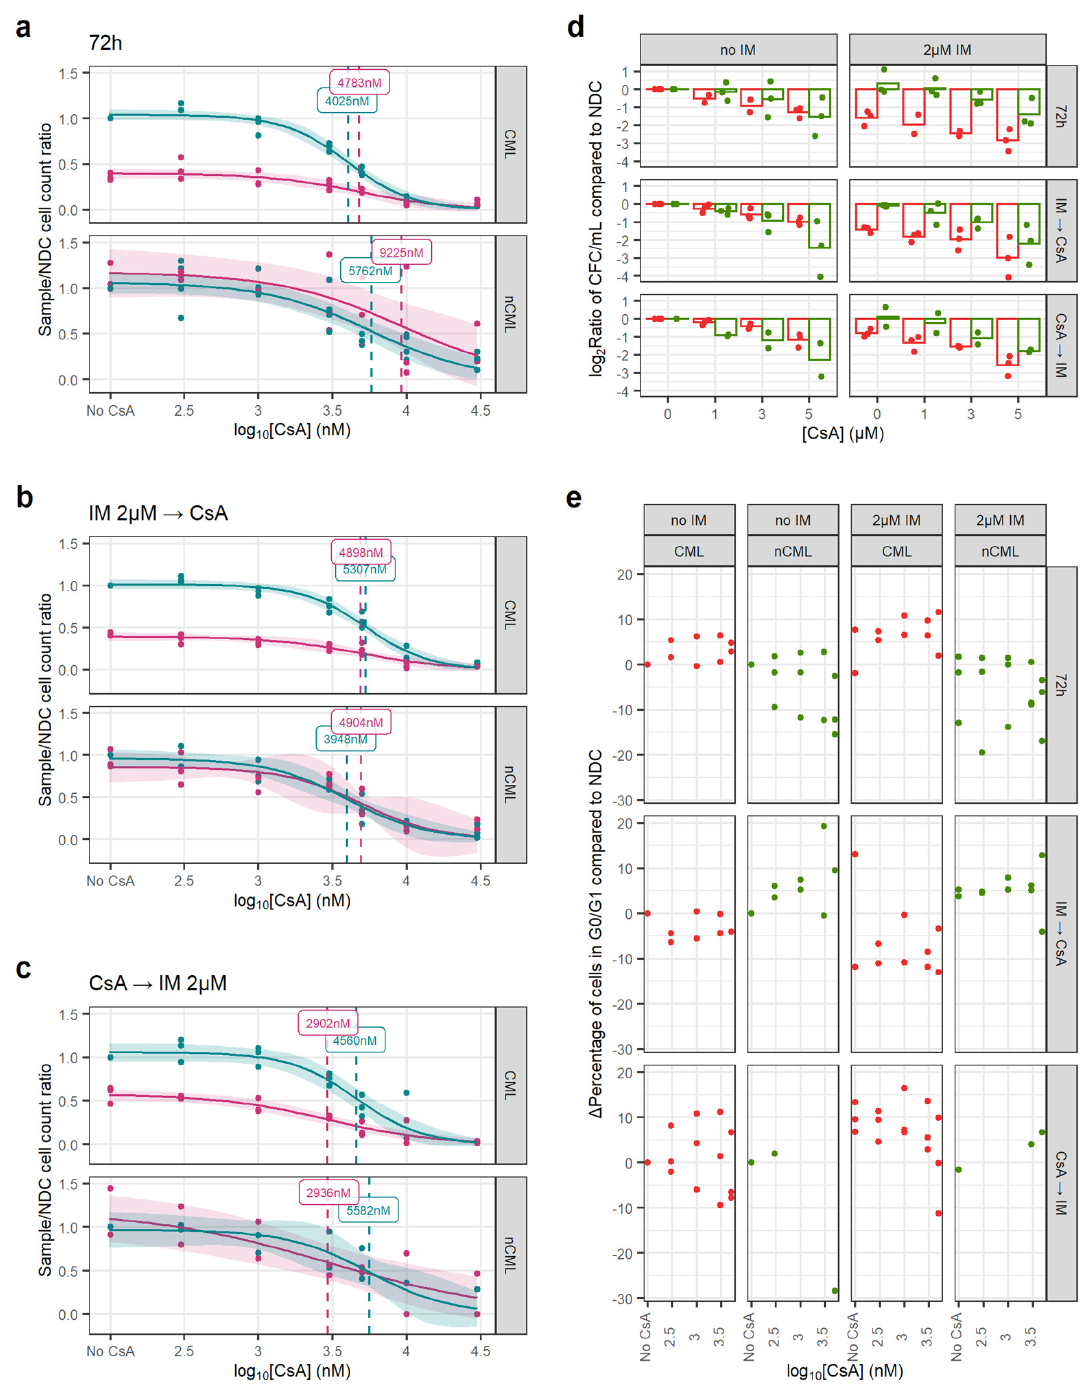
Figure 4. CsA eradicates CML CFC in combination with IM. ( a ) Dose–response curves for the CsA 72 treatment regimen. ( b ) Dose–response curve for the CsA IMCA treatment regimen. ( c )